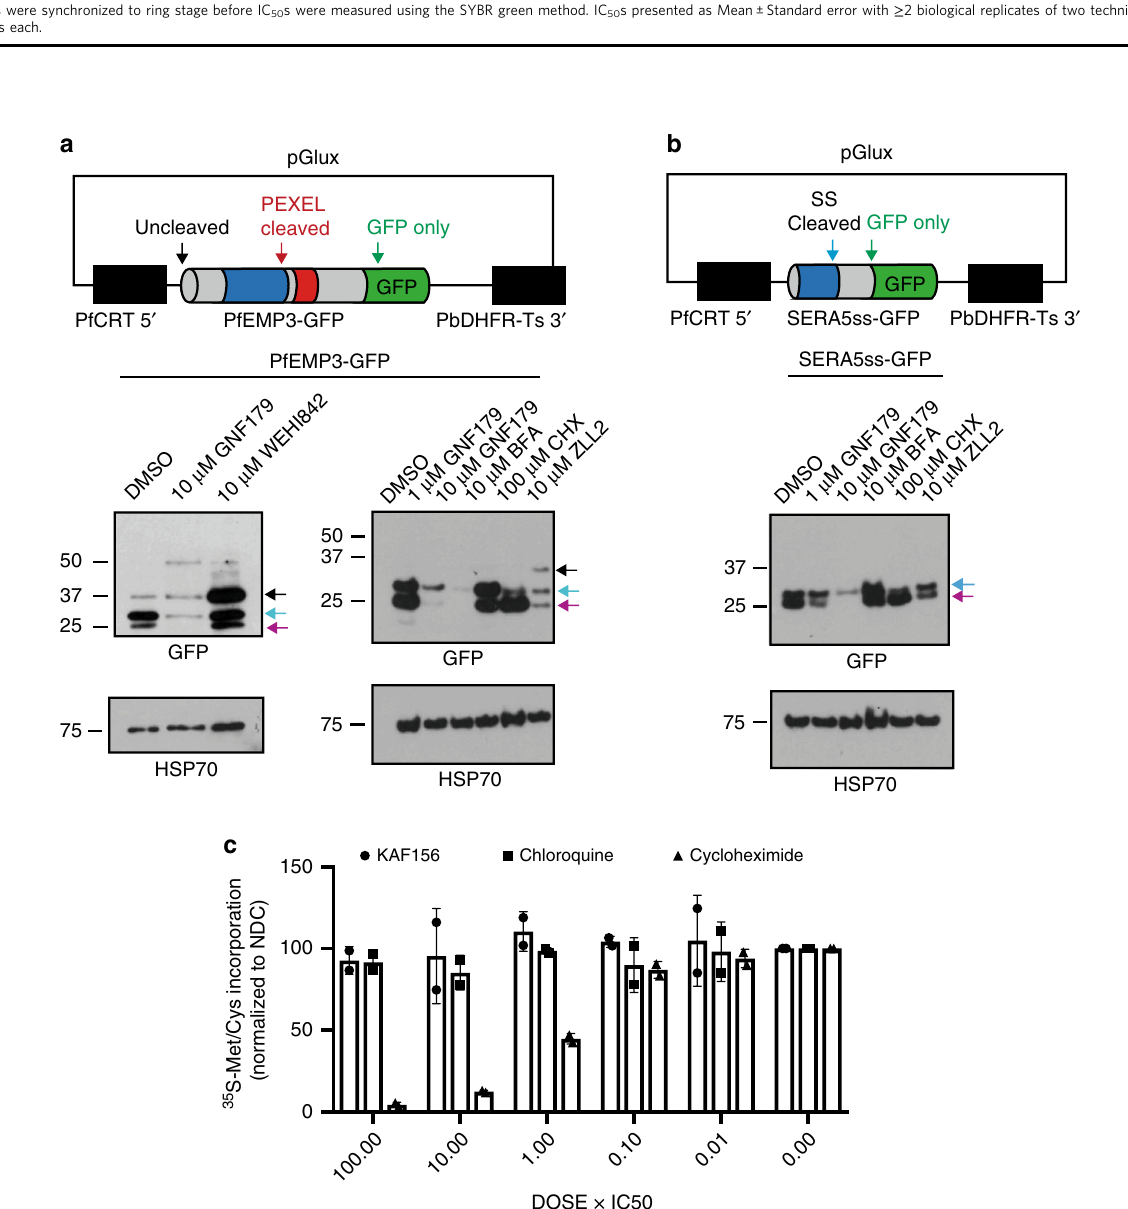
Fig. 3 Secretion reporter constructs demonstrate that GNF179 inhibits protein export of Plasmodium falciparum. a Protein expression levels of PfEMP3- GFP reporter. This fusion includes the signal peptide and PEXEL motif of PfEMP3. By immunoblot, three protein products are seen with anti-GFP antibodies. The three indicated bands, in response to probing with GFP, as follows: 1. Full length protein (black arrow), 2. PEXEL cleaved protein (blue arrow), 3. GFP degradation product (magenta arrow). HSP70 is used as a loading control. b SERA5ss-GFP fusion reporter treated with GNF179. By immunoblot with anti- GFP antibodies we see two protein products for this construct: 1. Signal peptide cleaved (blue arrow) and 2. GFP degradation product (magenta arrow). HSP70 serves as a loading control. c 35 S incorporation of newly synthesized amino acids at different concentrations of KAF156, chloroquine (negative control for inhibition) and cycloheximide (positive control for inhibition). Counts were normalized to data obtained from no-drug controls (NDC) and presented as mean ± SD ( n = 2 independent experiments). Source data for c is provided as a Source Data fi